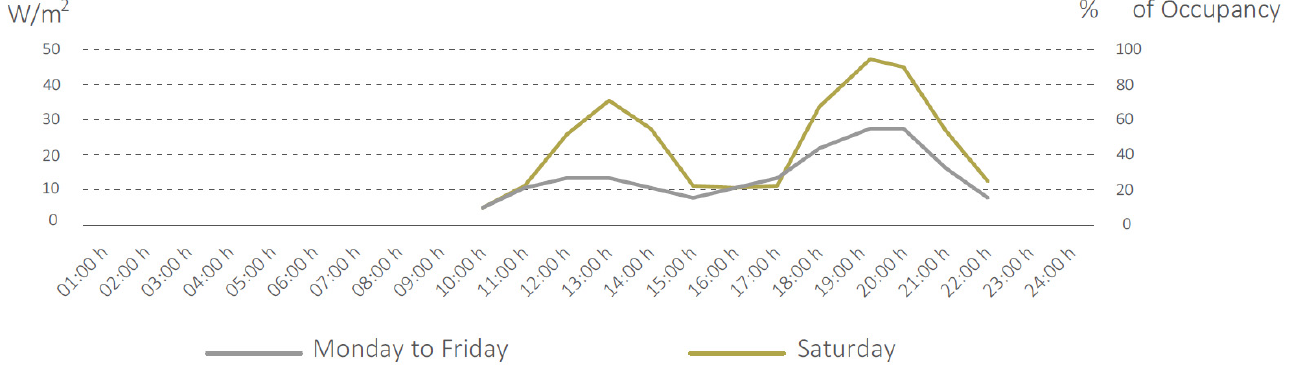
Figure 4. Internal load schedule. * Considering a ratio of 0.32-person m − 2 of occupancy. ** Consider- ing 120 W of sensible heat gains per person [45].